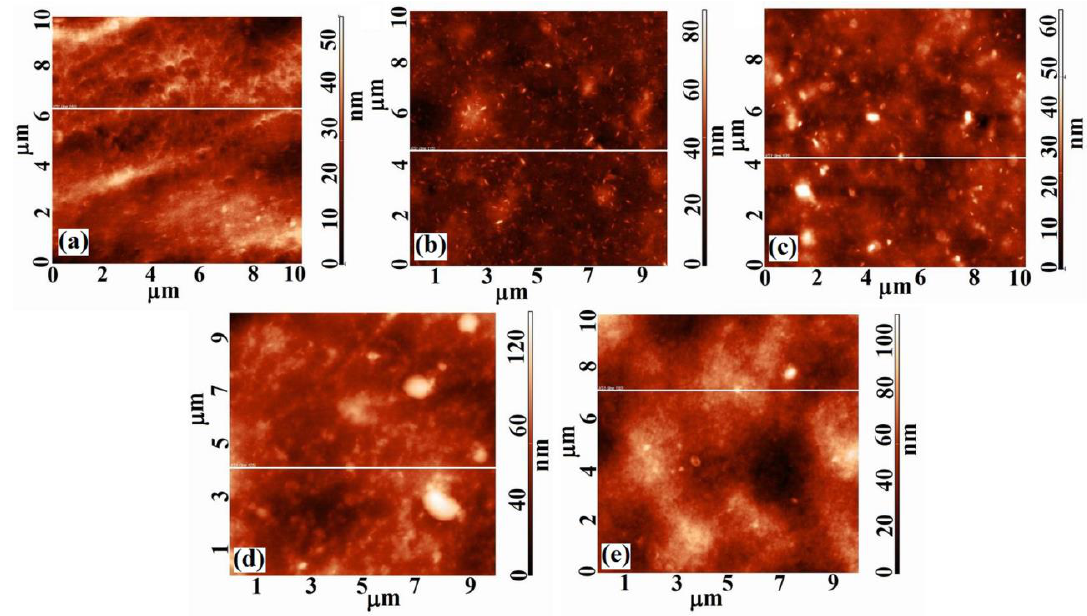
2 10 10μm  Figure 1. 2D AFM images obtained over 10 × 10 µ m 2 scan area for ( a ) CA, ( b ) CA+0.5 wt.% TEOS, ( c ) CA+1.0 wt.% TEOS, Figure 1. 2D AFM images obtained over scan area for ( a ) CA, ( b ) CA+0.5 wt.% TEOS, ( c ) CA+1.0 wt.% TEOS, ( d ) CA+1.5 wt.% TEOS and ( e ) CA+2.0 wt.% TEOS ( d ) CA+1.5 wt.% TEOS and ( e ) CA+2.0 wt.% TEOS films.